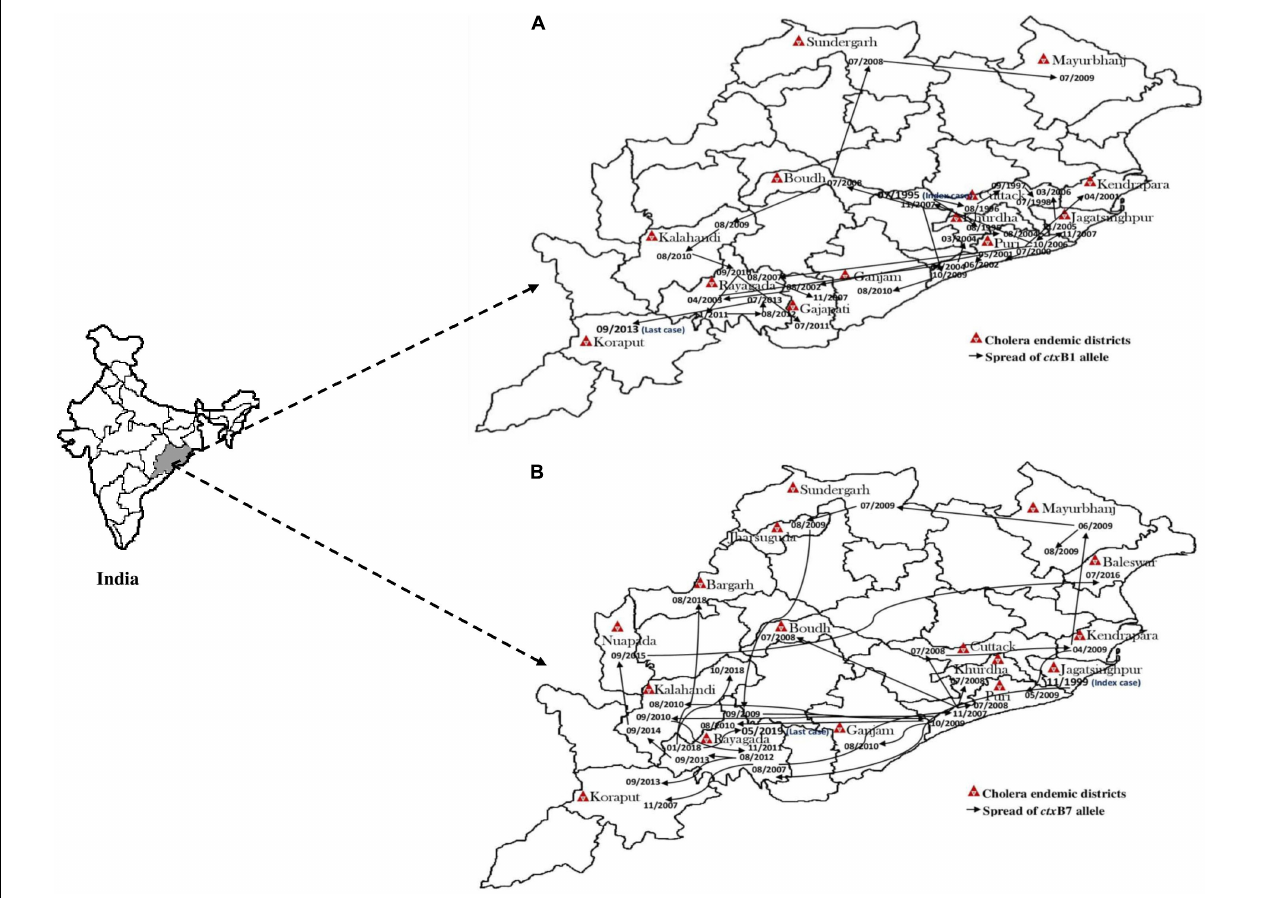
FIGURE 4 | Month- and year-wise spread of El Tor variant Vibrio cholerae O1 strains. (A) Spread of ctx B1 (B) spread of ctx B7 genotypes in Odisha: